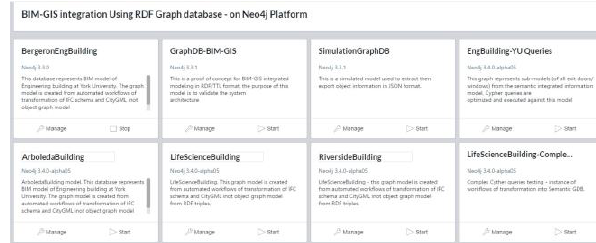
Figure 8: Neo4j admin console showing model and sub- models created during the system validation phase